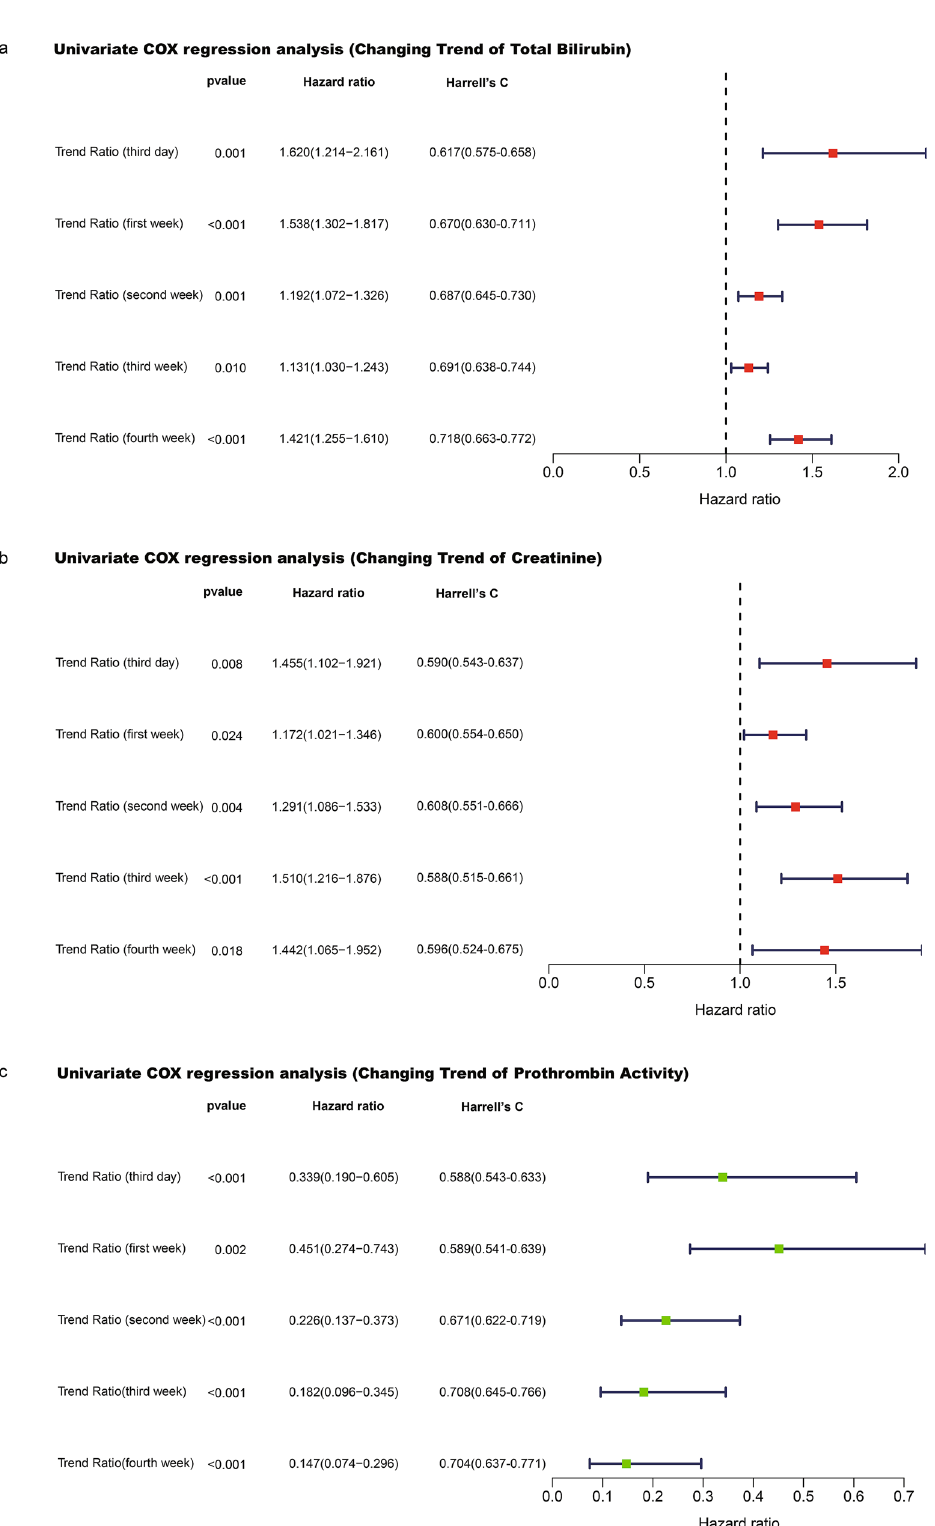
Figure 3. ( a ) Elevated levels of total bilirubin at the third day and first, second, third, and fourth weeks after admission were risk factors for death. The Harrell’s C index of model fitting degree showed an increasing trend with the extension of time. ( b ) Elevated levels of creatinine at the third day and first, second, third, and fourth weeks after admission were risk factors for death. The Harrell’s C index of model fitting degree increased to the highest value at the second week, and decreased slightly at other time points. ( c ) Declined levels of prothrombin activity at the third day and first, second, third, and fourth weeks after admission were all risk factors for death. The Harrell’s C index of model fitting degree showed an increasing trend with the extension of